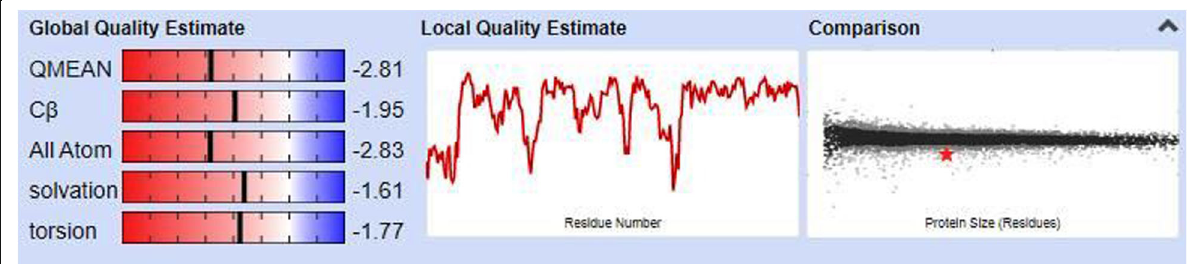
Fig. 6 Evaluation of protein model. Based on QMEAN score and Z score, a good quality model was